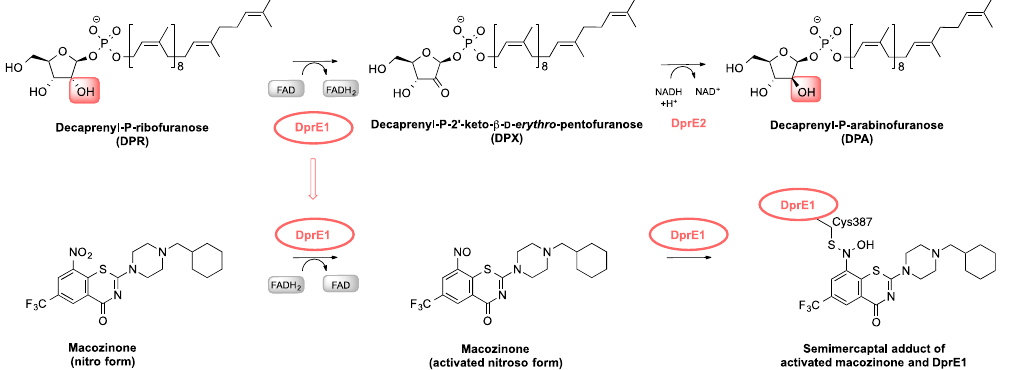
Figure 2. Mechanism of action of macozinone. Upper line: Reactions catalyzed by DprE1 and DprE2. Bottom line: Activation of macozinone and its covalent attachment to DprE1 from M. tuberculosis through Cys387 of the enzyme’s active site. The scheme is based on mechanistic studies performed initially with benzothiazinone BTZ043 [17–19] and subsequently confirmed for piperazine-benzothiazinone PBTZ169 (macozinone) [20].